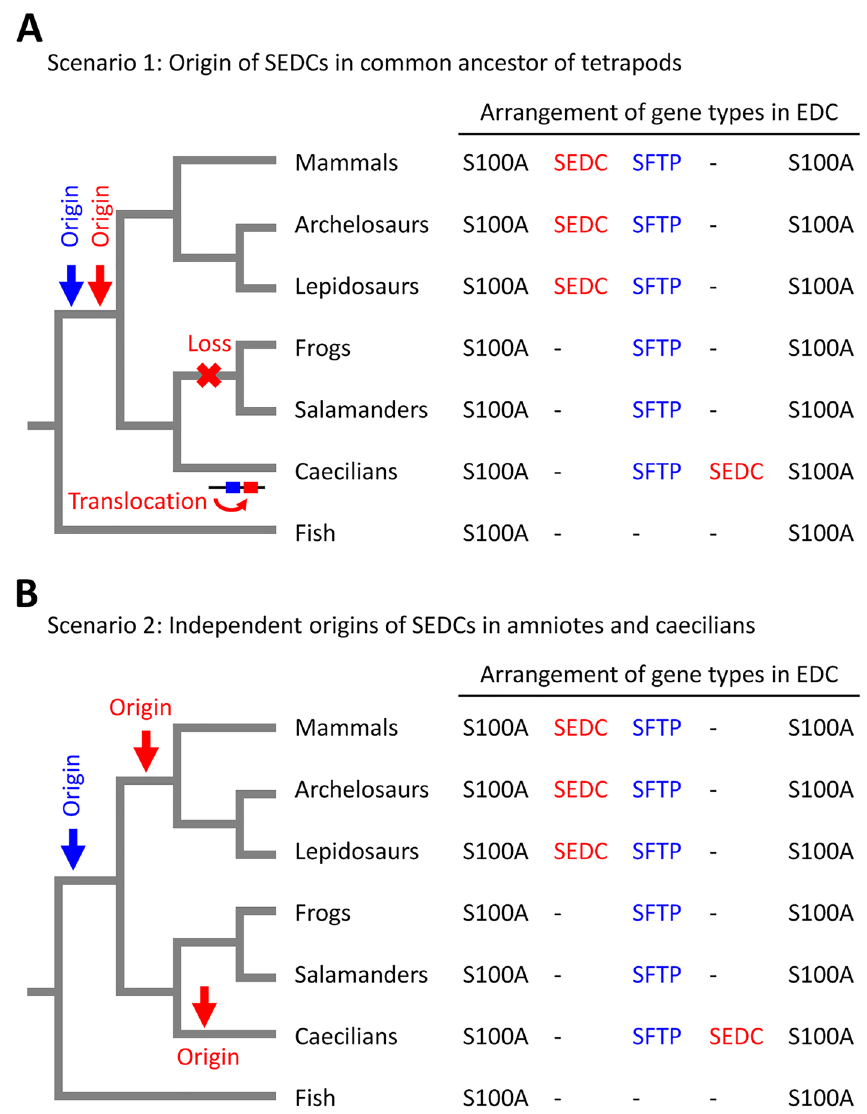
Figure 4. Scenarios for the evolution of SEDC genes in tetrapods. Two alternative scenarios ( A , B ) for the evolution of SEDC genes in terrestrial vertebrates are schematically depicted. Both scenarios are compatible with the arrangement of gene types in the epidermal differentiation complex (EDC) of caecilians and other main taxa of vertebrates. The relative arrangement of SEDC, SFTP and S100A genes within the EDC of each taxon is indicated on the